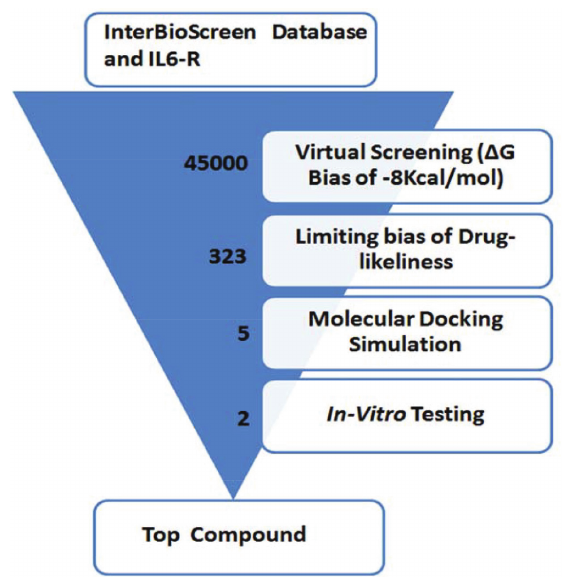
FIGURE 2 - Method used for screening of natural compounds against IL-6R.